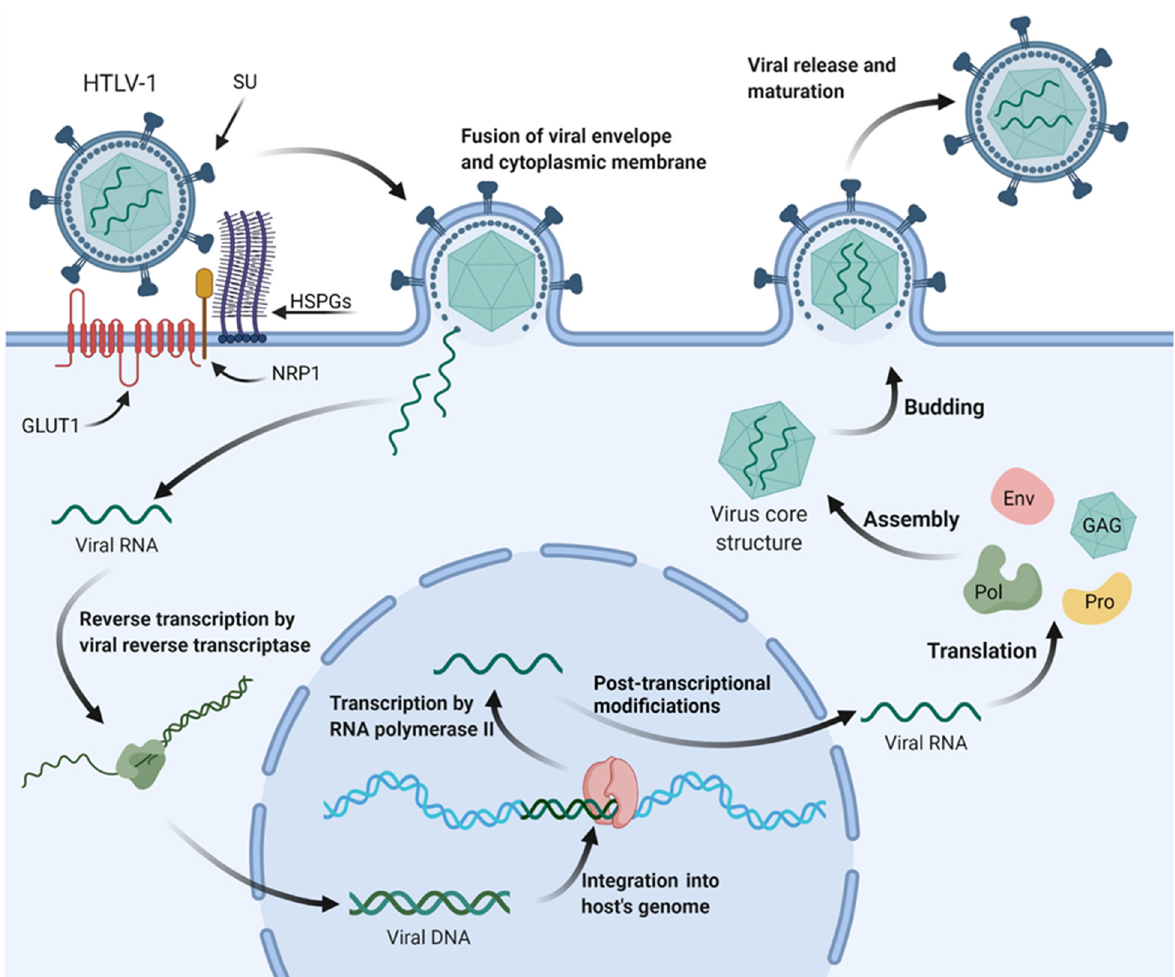
Figure 1. HTLV-1 mechanisms of cell infection and replication. Surface subunit (SU) of HTLV-1 glycoproteins interacts with heparan sulfate proteoglycans (HSPGs) of the targeted cell’s cytoplasmic membrane. A complex is then formed between the viral envelope, HSPGs, neuropilin-1 (NRP1), and glucose transporter-1 (GLUT1). The envelope fuses with the cytoplasmic membrane, and the